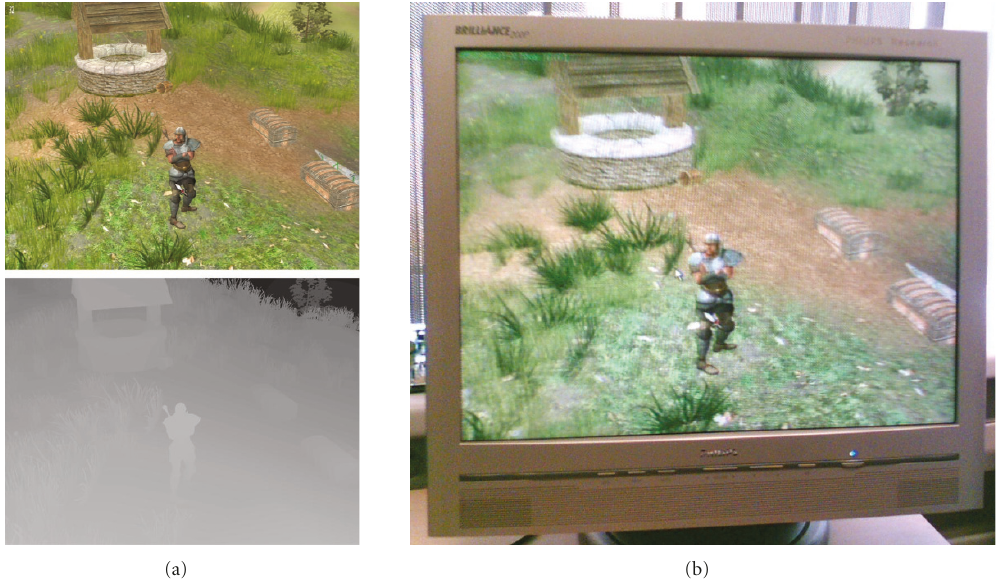
Figure 14: Screen shot of GOAL: image and depth bu ff ers (a), and actual image on autostereoscopic 3D display